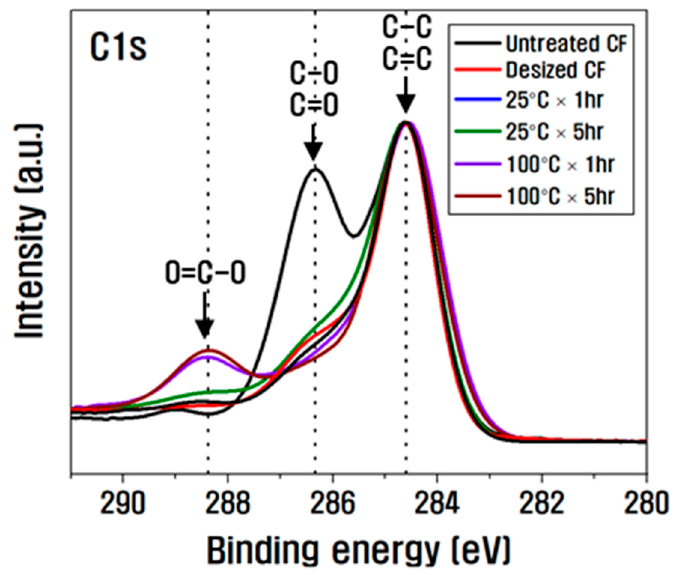
Figure 3. C1s XPS spectra of chemical treatment according to temperature and treatment time. Table 2. Effect of chemical treatment conditions on the surface elemental composition of carbon